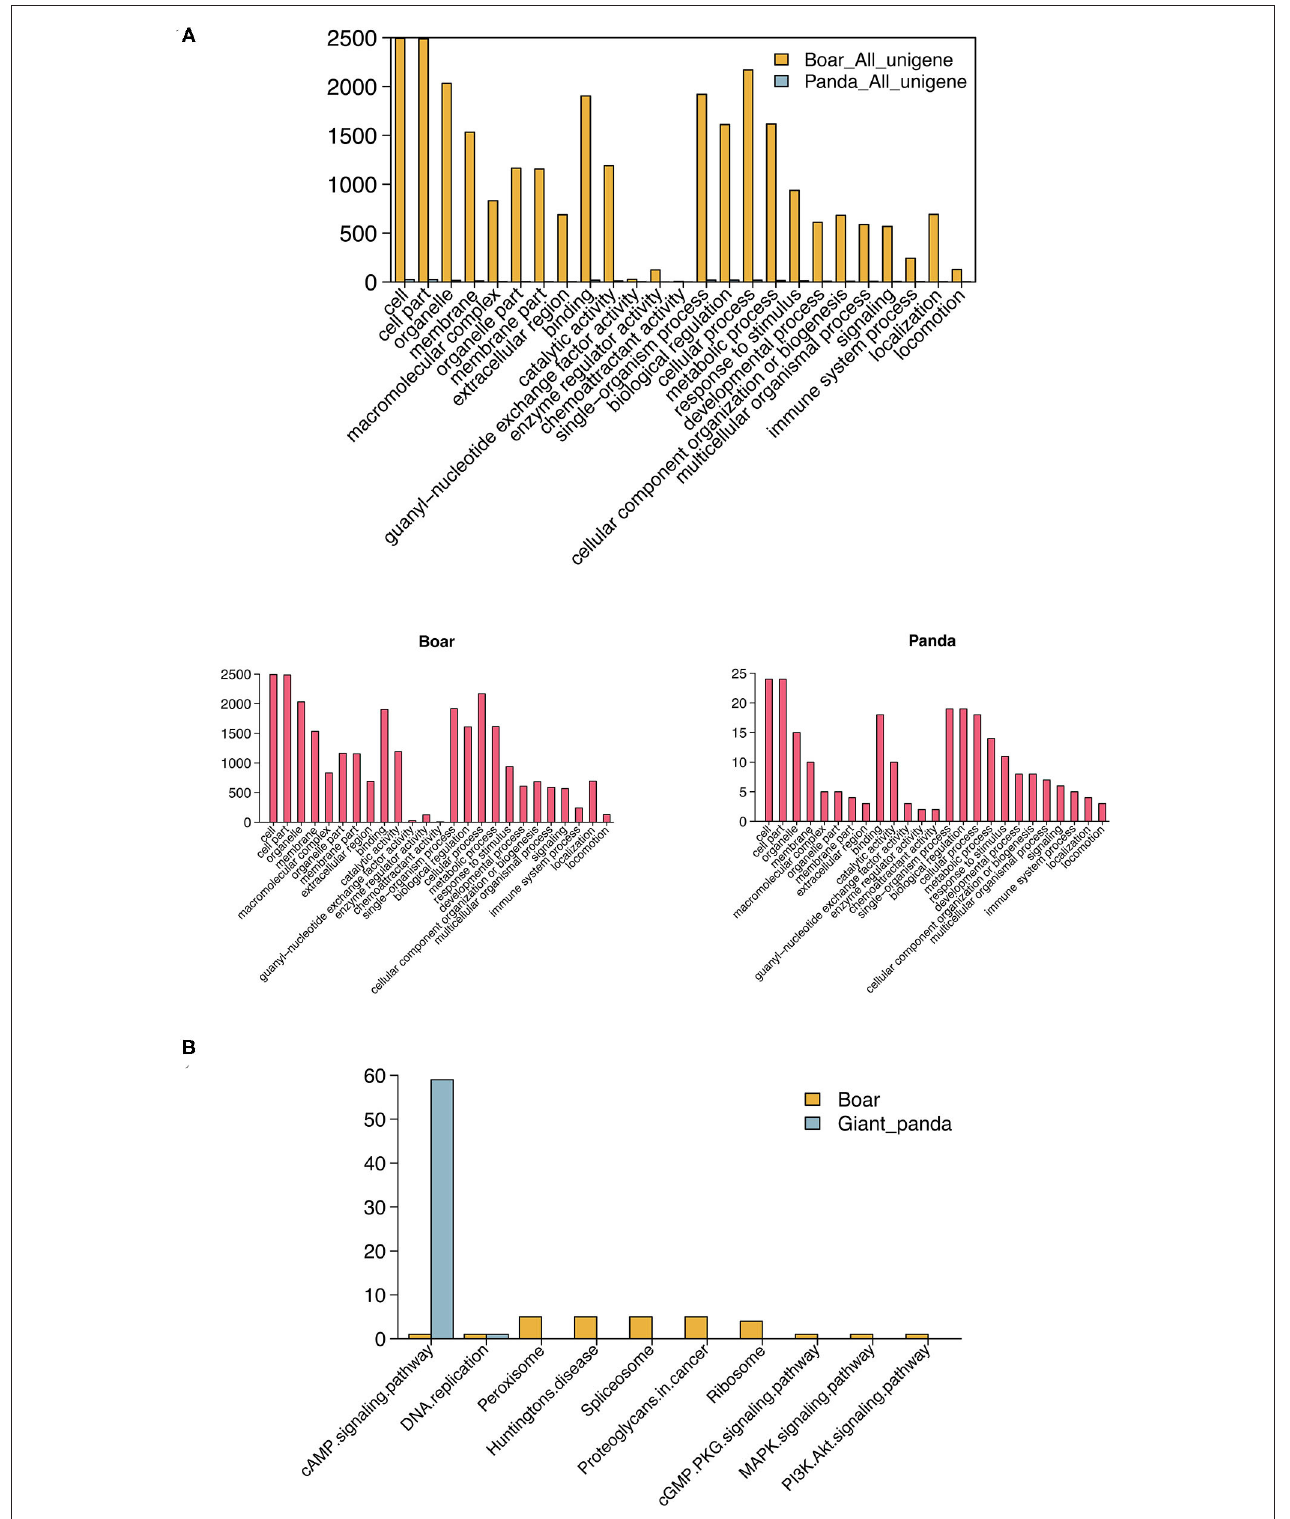
FIGURE 3 | Gene Ontology (GO) and Kyoto Encyclopedia of Genes and Genomes (KEGG) analysis of differentially expressed PIWI-interacting RNAs (DE piRNAs) in giant panda and boar sperm. (A) GO analysis of the target DE messenger RNAs (mRNAs) of DE piRNAs. (B) Top 10 KEGG pathways of the target DE mRNAs of DE